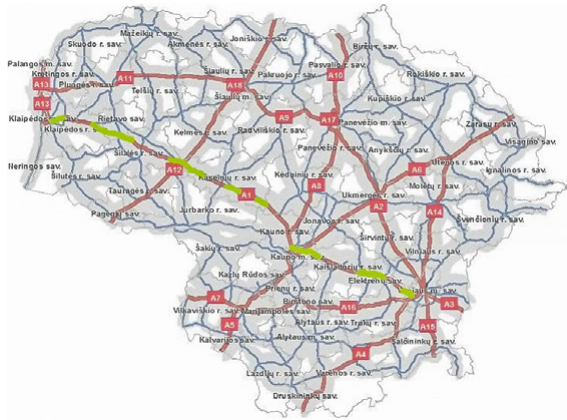
Fig. 4. The arrangement of average speed gauges on the right side of the road